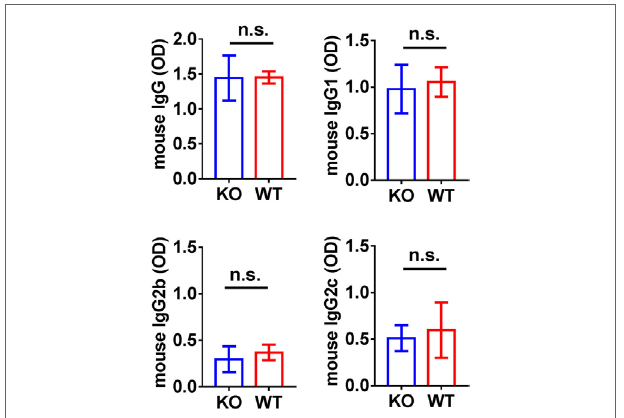
FigUre 5 | Analysis of circulating anti- α 3NC1 mouse IgG antibodies. The levels of circulating mouse IgG, IgG1, IgG2b, and IgG2c antibodies binding to rh- α 3NC1 were measured by indirect ELISA. Mouse sera were diluted 1/5,000 for total IgG, 1/2,000 for IgG1, and 1/500 for IgG2b and IgG2c. The significance of differences between Cfb − / − (KO) and Cfb + / + (WT) mice was evaluated by t -test (n.s., not